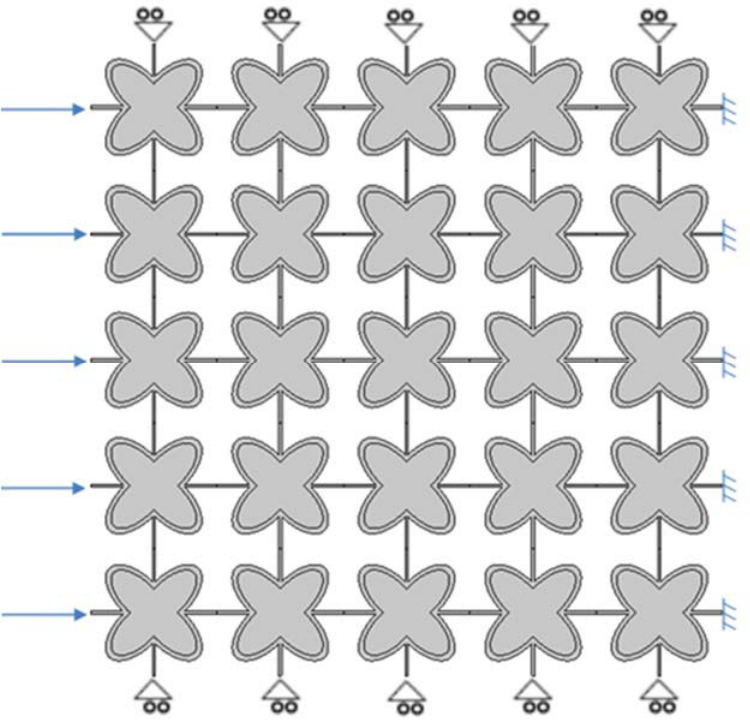
Figure 16. Mesh structure for verification with 25 representative volume elements.